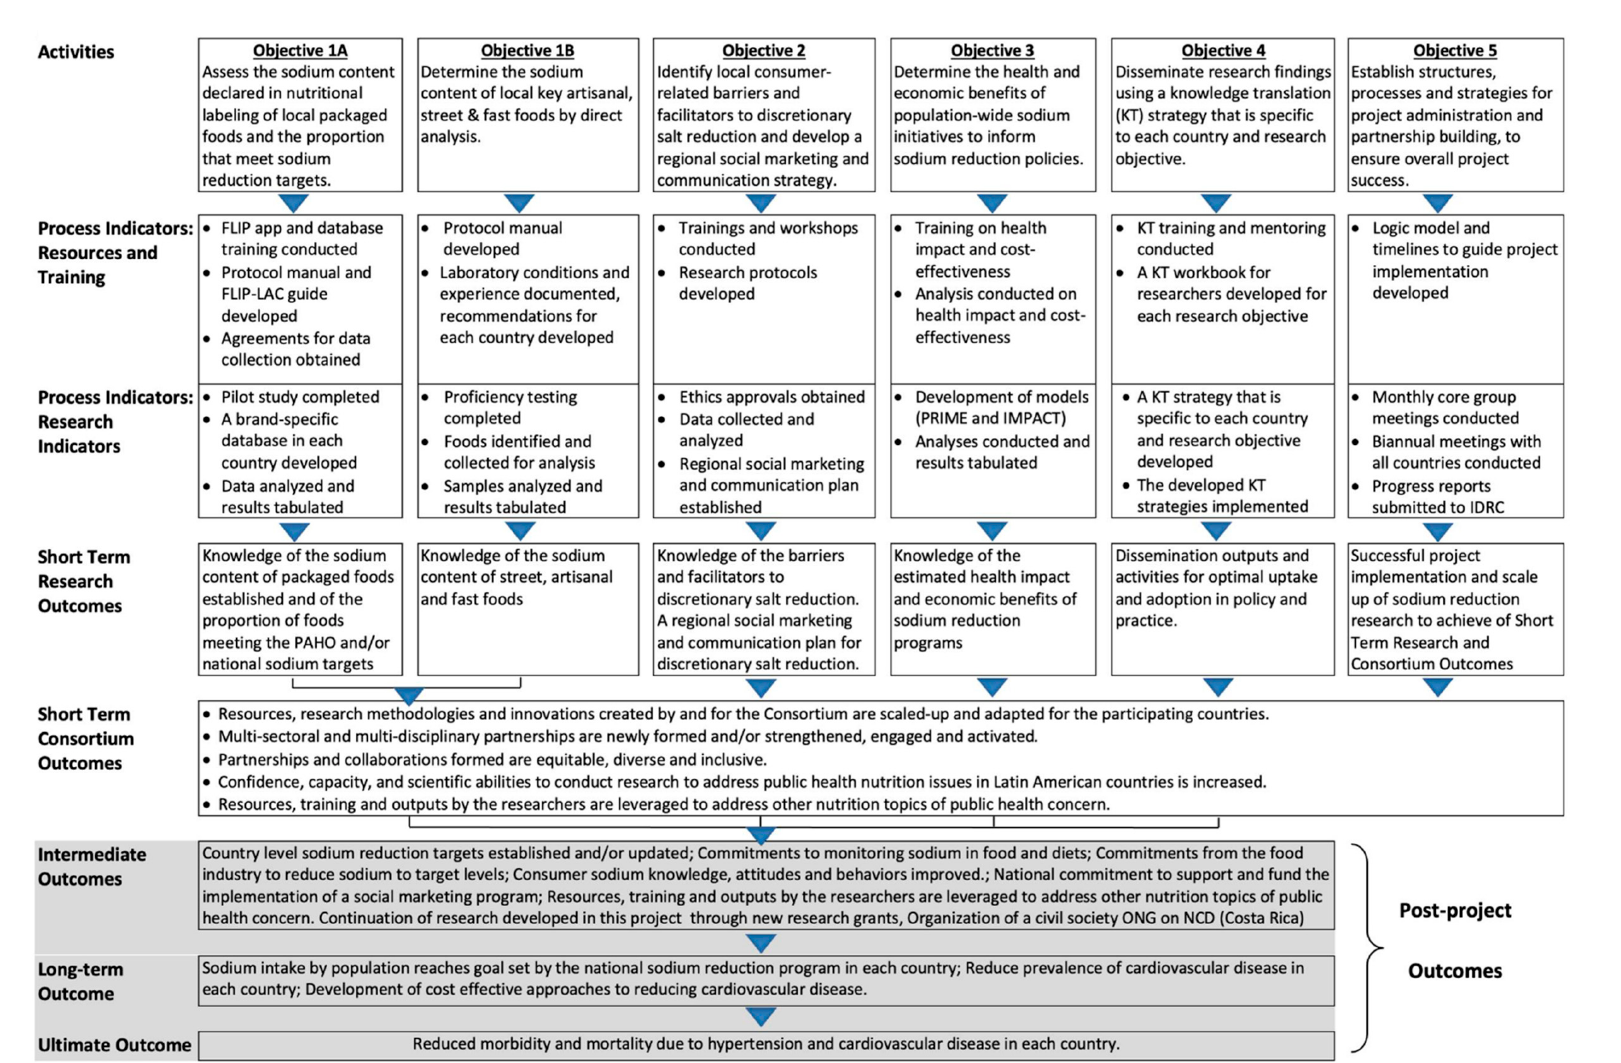
Figure 1. Research Program Logic Model.